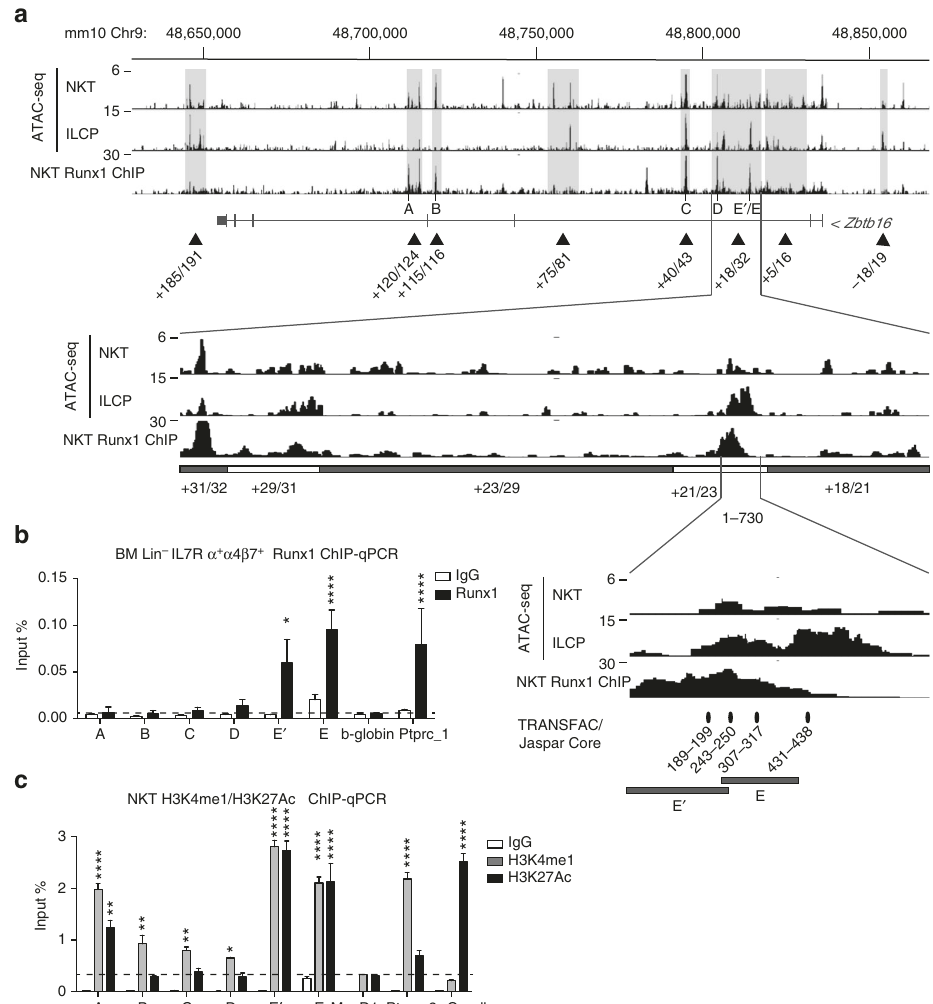
Fig. 6 ChIP analysis of Runx1 binding. a Runx1 ChIP-seq pro fi le of the Zbtb16 locus in NKT thymocytes aligned with corresponding ATAC-seq pro fi les in NKT thymocytes and ILCP cells, with magni fi cation of regions + 18/32 and 1/730 as indicated. b Runx1 ChIP-qPCR analysis of BM Lin - IL7R α + α 4 β 7 + cells at sites A – E as de fi ned above. Ptprc-1 and b-globin were used as positive and negative control, respectively. Data are combined from three independent experiments. c H3K4me1 and H3K27Ac modi fi cations at the Zbtb16 locus. Ptprc-2 and Gapdh were used as positive controls for H3K4me1 and H3K27Ac, respectively. MyoD1 was used as negative control for both. Data are summarized from three independent experiments. Statistical analysis by one-way ANOVA for multiple comparisons. * P < 0.05, ** P < 0.01, *** P < 0.001, **** P <